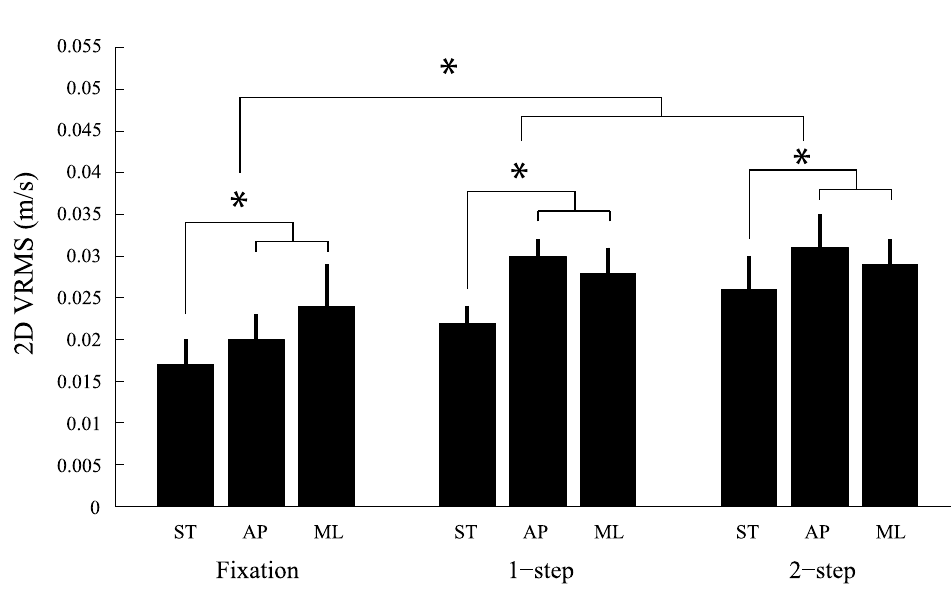
Fig 4. Mean 2-D velocity root mean square (vRMS) as a function of background stimulus (checkerboard conditions: ST = static, AP = anteroposterior, ML = mediolateral) and oculomotor task (fixation, 1-step saccade, 2-step saccade). Data from all subjects and trials were pooled.Error bars = standarderror of the mean. * denotesa significantdifference (p < 0.05).